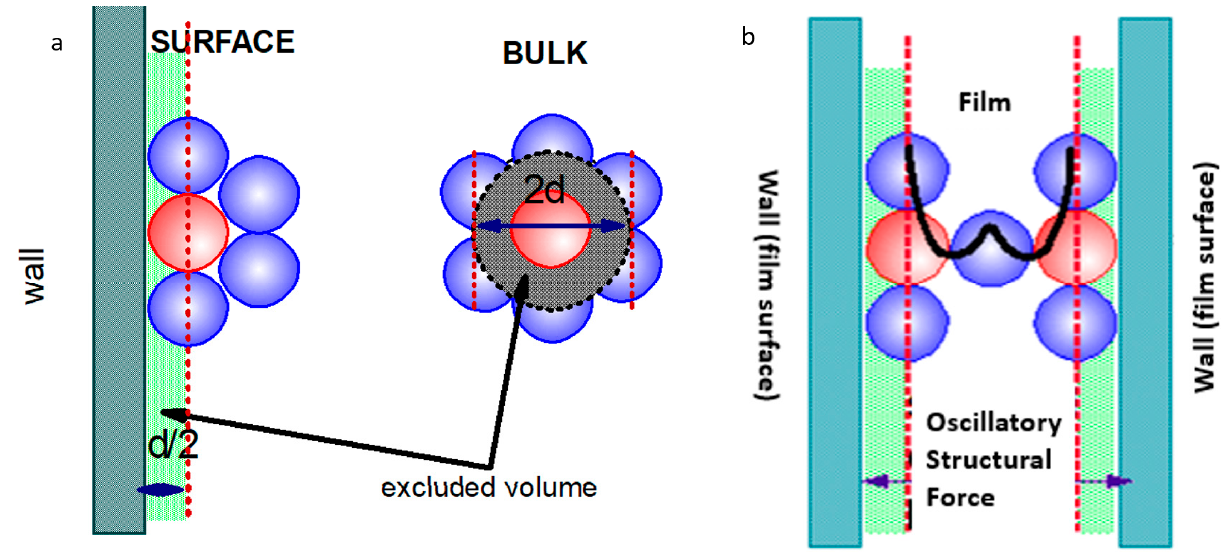
Figure 2. ( a ). Different excluded volume effects of particles in the bulk and close to the solid wall; ( b ) self-layering of nanoparticles under film confinement.